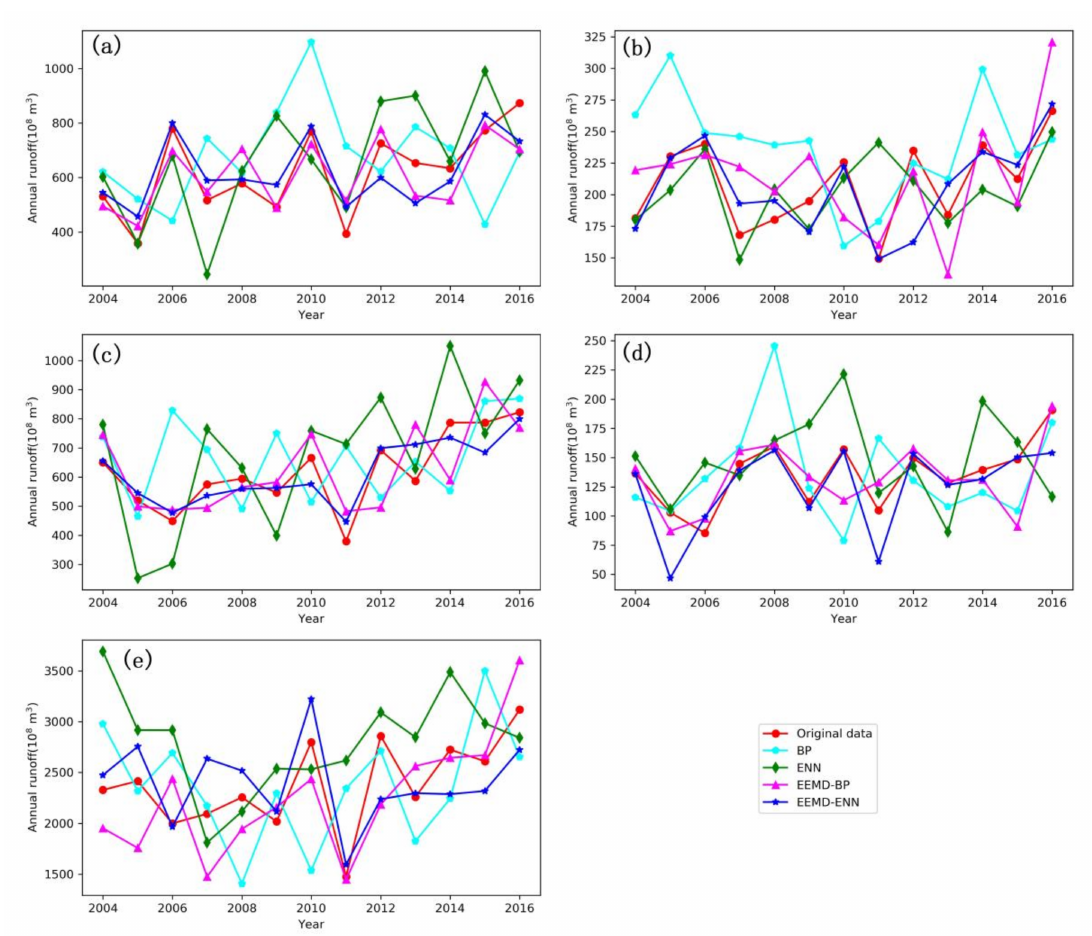
Figure 4. Performance comparison of the prediction results of the Back Propagation (BP), EEMD-BP, ENN and EEMD-ENN models. ( a ) Xiangtan station; ( b ) Taojiang station; ( c ) Taoyuan station; ( d ) Shimen station and ( e ) Chenglingji station.